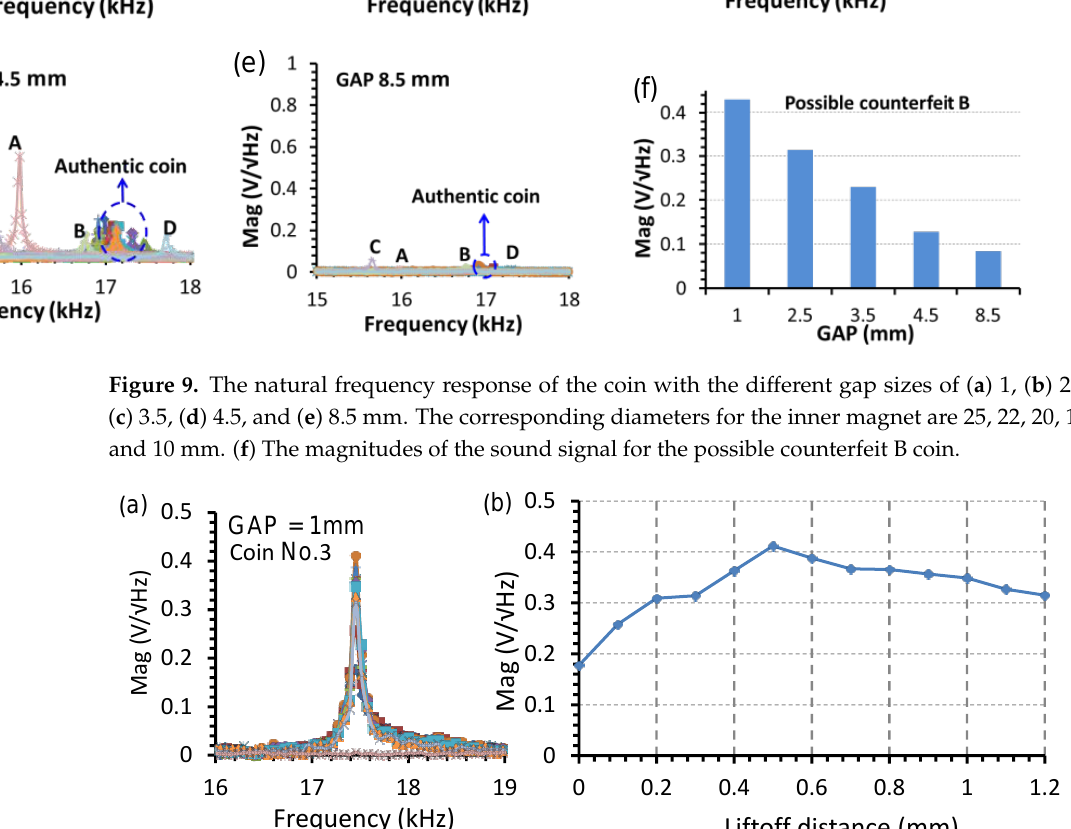
Figure 10. The natural frequency response of the coin No.3 tested with the EMAT with a 1 mm inter-magnet gap at the liftoff distance ranging from 0 to 1.2 mm: ( a ) the frequency spectra; ( b ) the spectral magnitude of the output voltage.